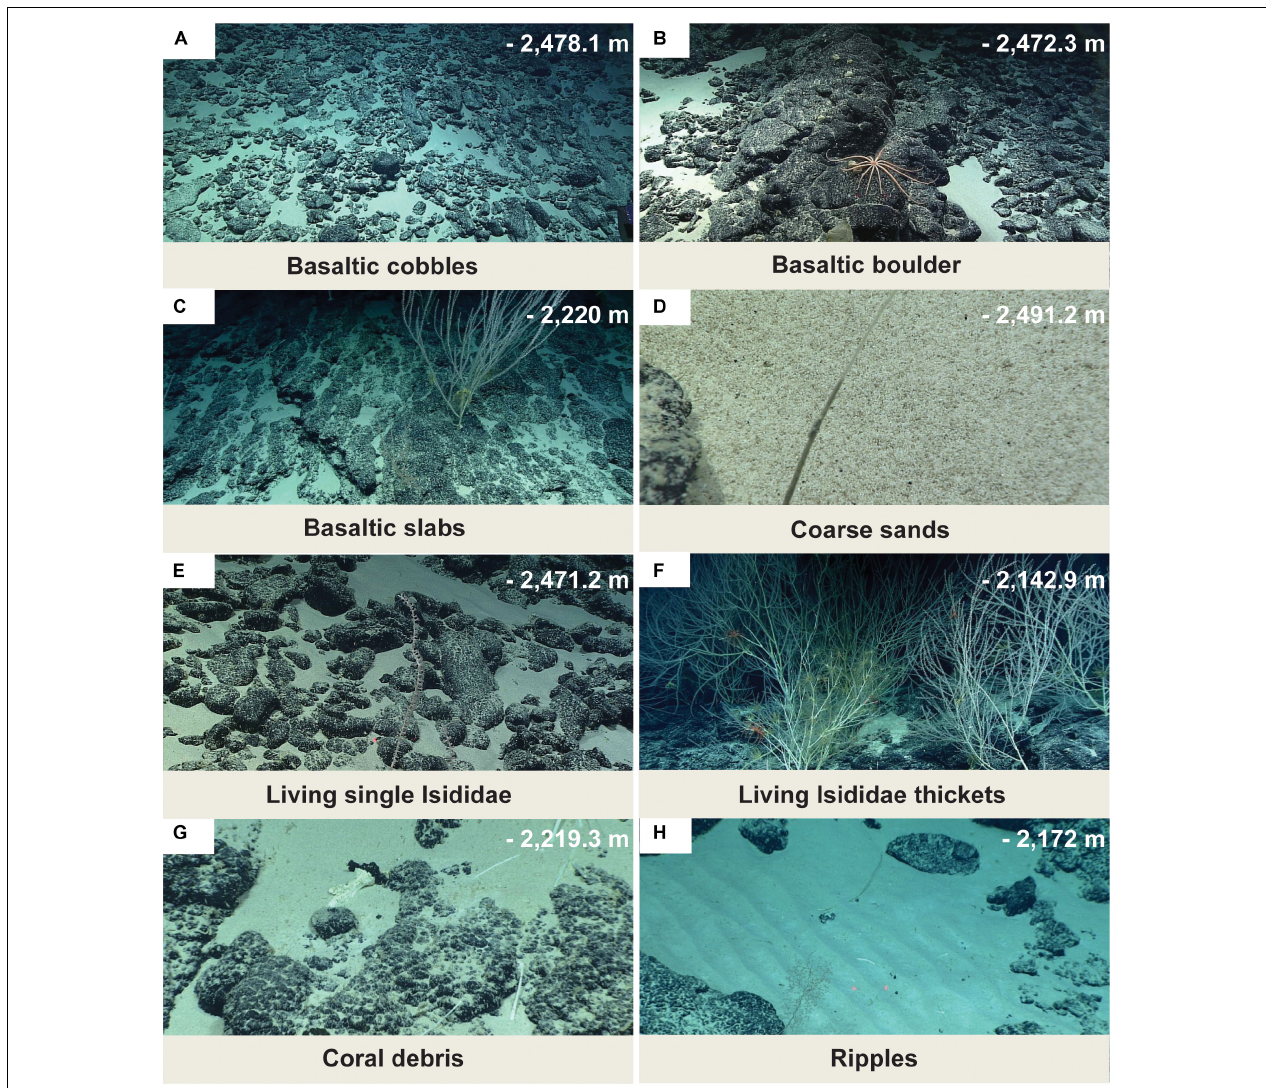
FIGURE 3 | Eight facies observed on the seafloor of the dive sites. (A) Ferromanganese-encrusted basaltic cobbles, (B) Ferromanganese-encrusted basaltic boulder, (C) Ferromanganese-encrusted basaltic slabs, (D) Coarse sands, (E) Living single Isididae, (F) Living Isididae thickets, (G) Coral debris, and (H) Ripples of coarse sediments between the basaltic boulders. Image courtesy of the NOAA’s Office of Ocean Exploration and Research, Mountains in the Deep: Exploring the Central Pacific